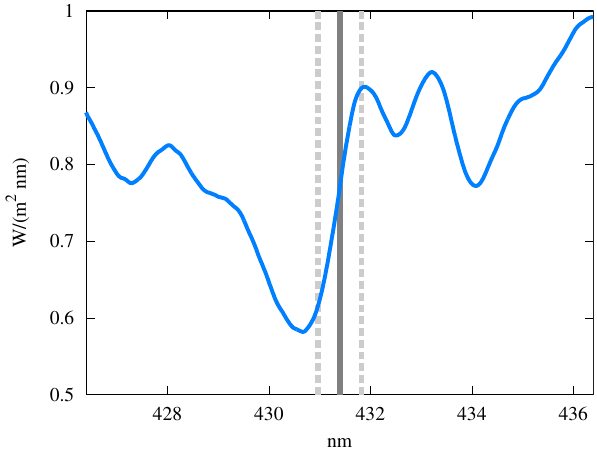
Figure 11. Effect of slight wavelength misalignments in Brewer measurements. (cid:49) AOD represents the difference of the AOD re- trieved at shifted wavelengths ( + 0.02nm) compared to the results using an unperturbed wavelength scale, as a function of the solar zenith angle.